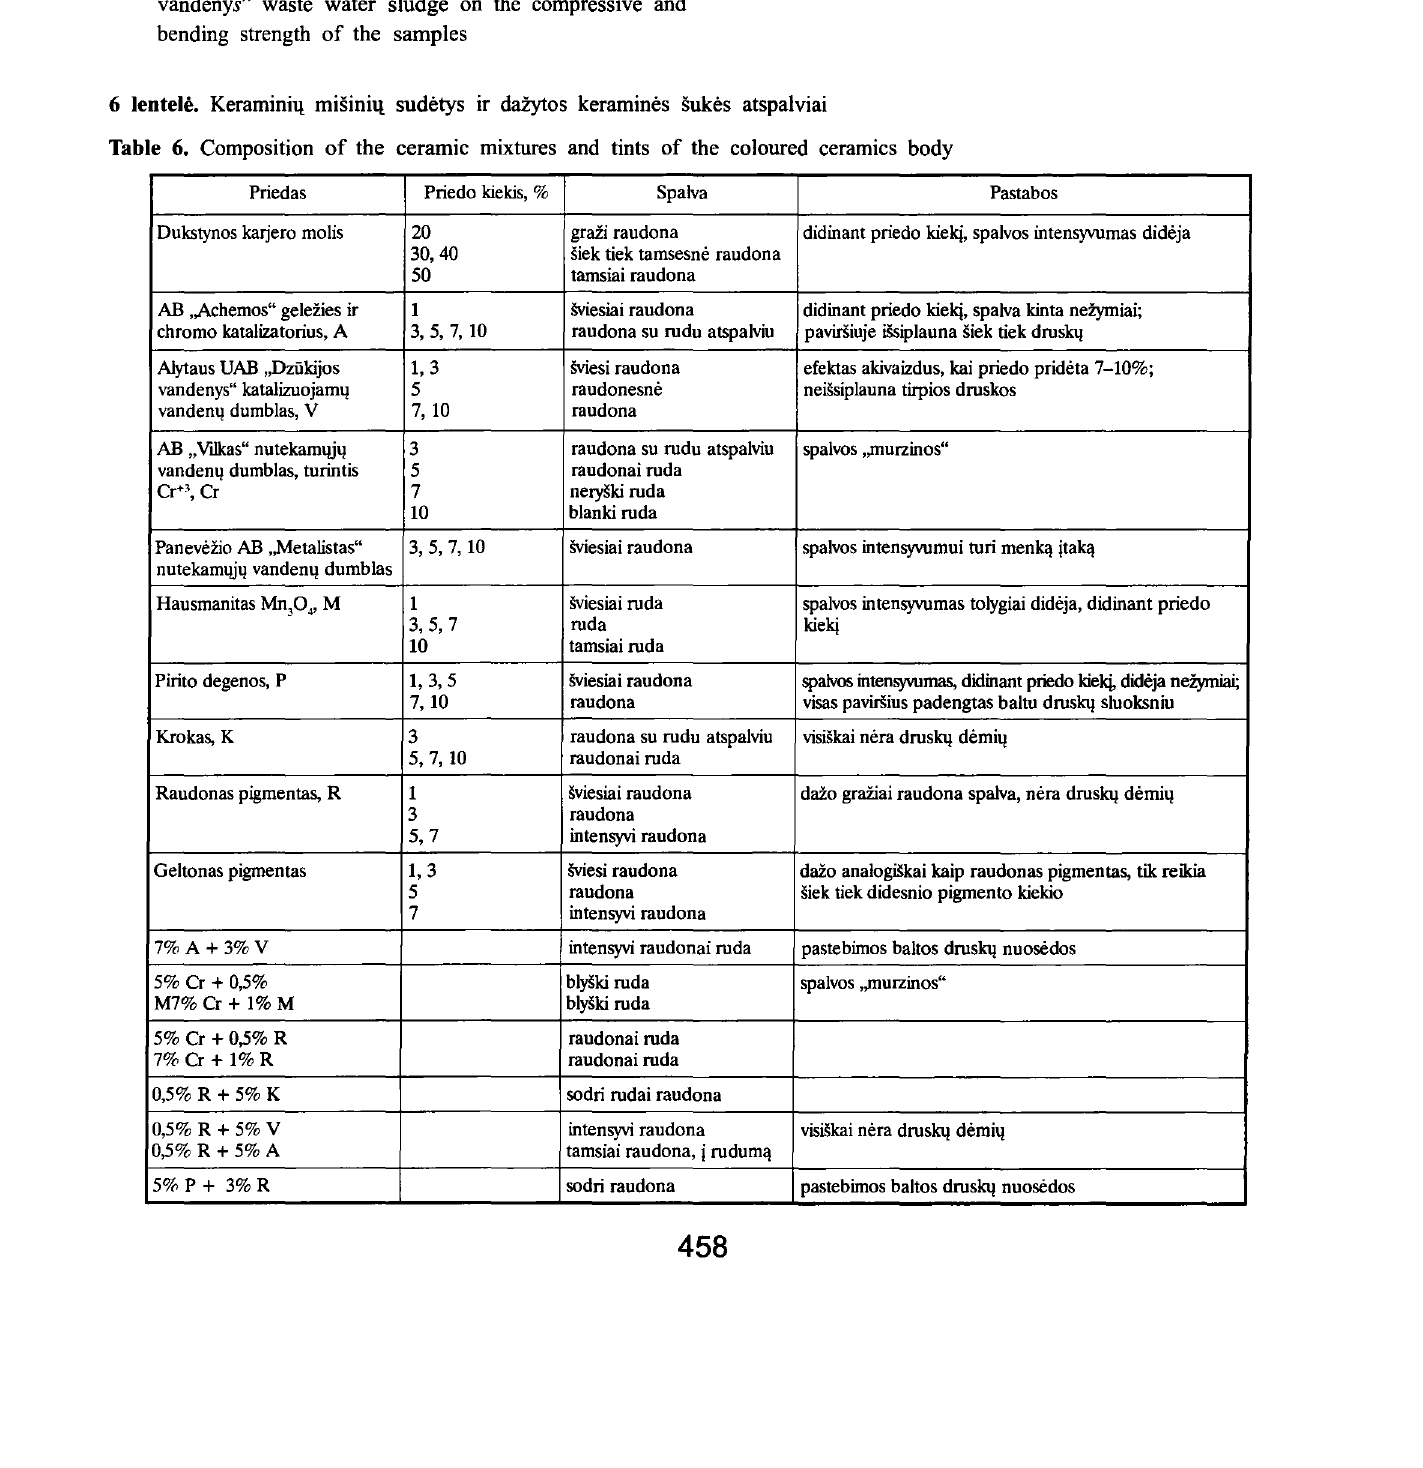
Table 6. Composition of the ceramic mixtures and tints of the coloured ceramics